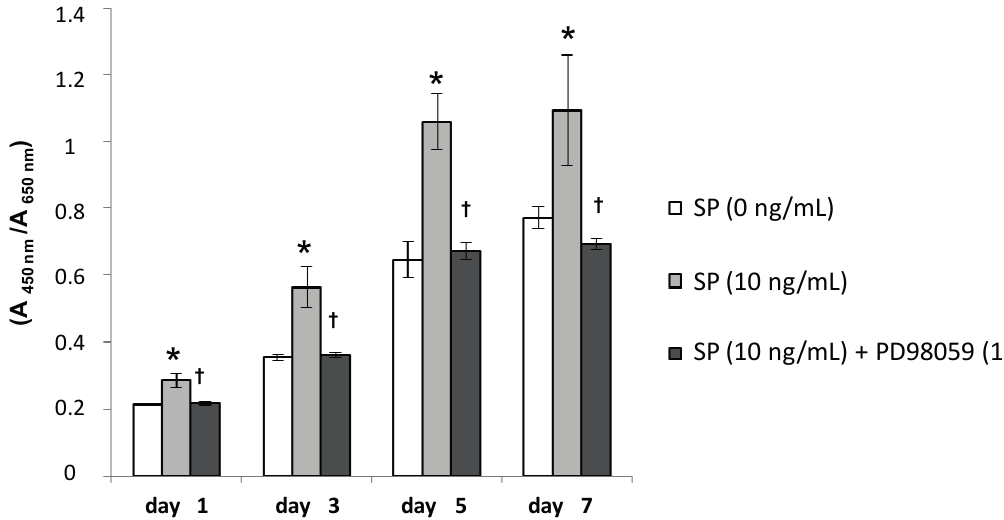
Figure 5. Effect of PD98059 on SP-induced cell proliferation. MSCs were seeded in 96-well plates at 2 × 10 3 cells/well in normal culture medium. After a 24 h culture for cell adherence, MSCs were cultured in normal culture medium containing SP (0 or 10 ng/mL), or SP (10 ng/mL) with the ERK 1/2 inhibitor PD98059 (10 µM). Cell proliferation was measured on days 1, 3, 5 and 7. * p < 0.05, SP (0 ng/mL) vs. SP (10 ng/mL), † p < 0.05,